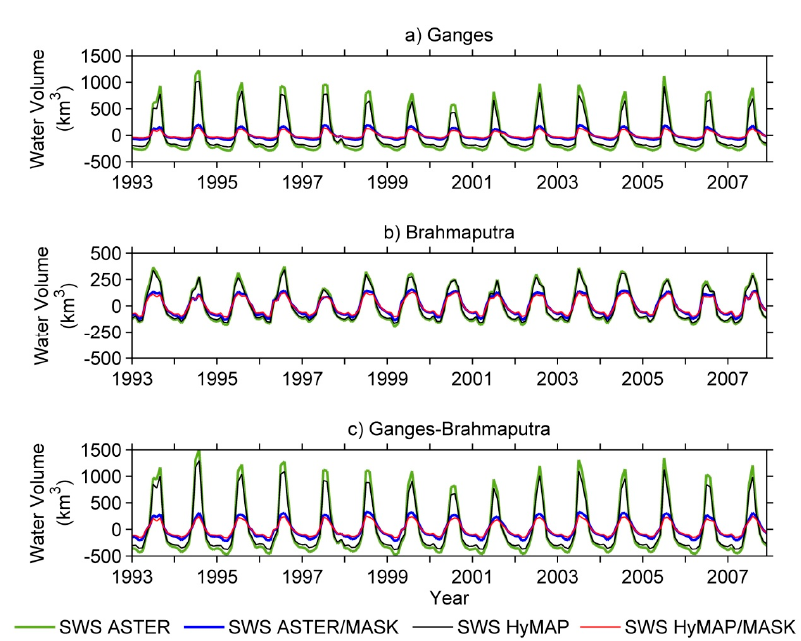
Figure 6. Monthly mean surface water storage variations for the period 1993–2007 estimated by the combination of GIEMS water extents (before and after the usage of a MODIS mask) and a GDEM (ASTER or HyMAP) over: ( a ) Ganges; ( b ) Brahmaputra, and ( c ) Ganges-Brahmaputra River basins. The variations of SWS (Figure 6) after the use of the MODIS mask maintain a similar variation pattern (correlation coefficients higher than 0.94 over G, B and GB for ASTER and HyMAP) along with a significant decrease in amplitude. For the entire GB system, SWS ASTER mean amplitude decreases from ~1612 km 3 to ~496 km 3 and SWS HyMAP mean amplitude decreases from ~1339 km 3 to ~378 km 3 . Mean annual amplitudes estimated using the two techniques (GIEMS-MODIS/GDEM and GIEMS-MODIS/Alt) over G, B and GB are given in Table 1. The magnitude of SWS corrections is higher in the Ganges than the Brahmaputra; this might be the result of relatively higher agricultural coverage in the Ganges basin. These results are consistent with the evaluation of SWS over the GB SWS/TWS ratio ~0.45. The Pearson correlation coefficient calculated between SWS estimated by the two techniques is higher than 0.95 for the different couples of time series (SWS GIEMS/Alt–SWS GIEMS/ASTER and SWS GIEMS/Alt-SWS GIEMS/HyMAP) over G, B, and GB.